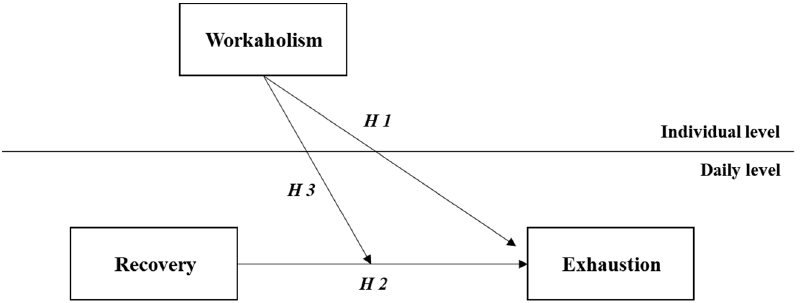
Figure 1. Hypothesized model.